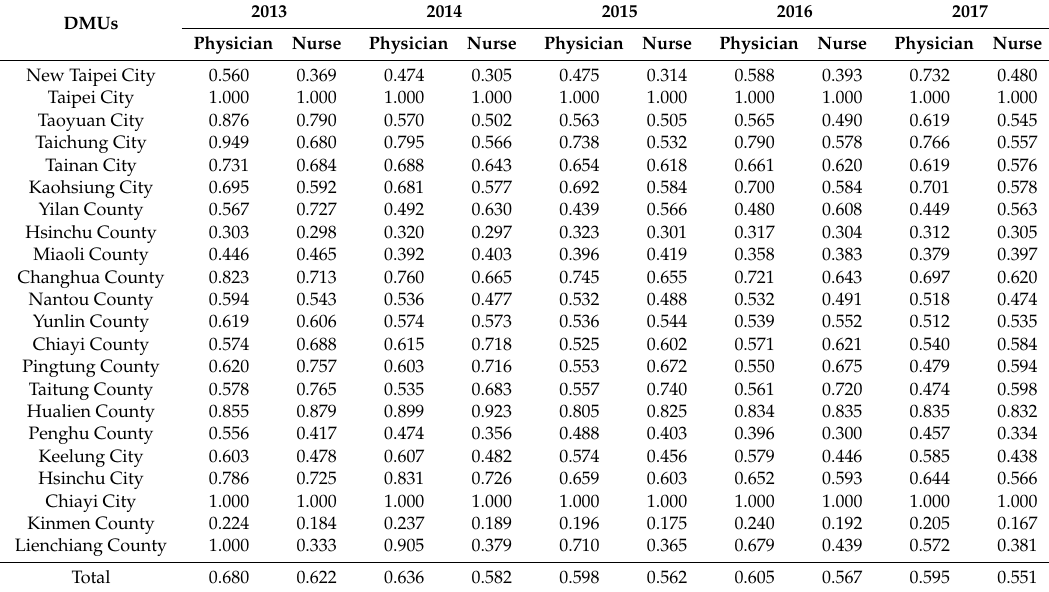
Table A2. The carrying e ffi ciency of medical sta ff for each administrative region in Taiwan.